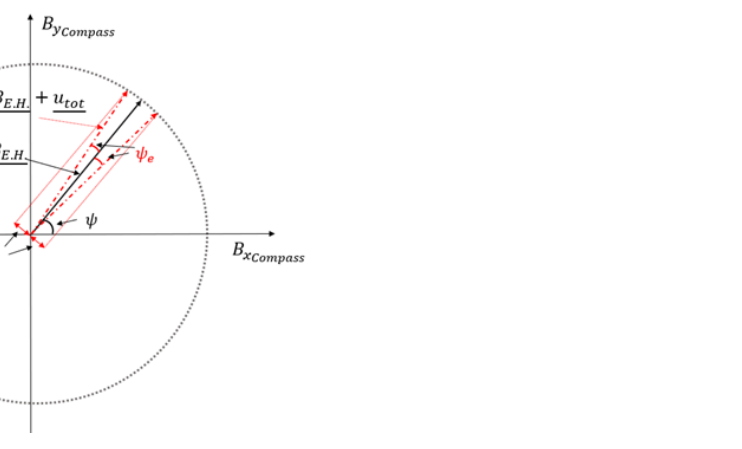
Figure 4. The worst-case scenario is reached when 𝐵 𝑥